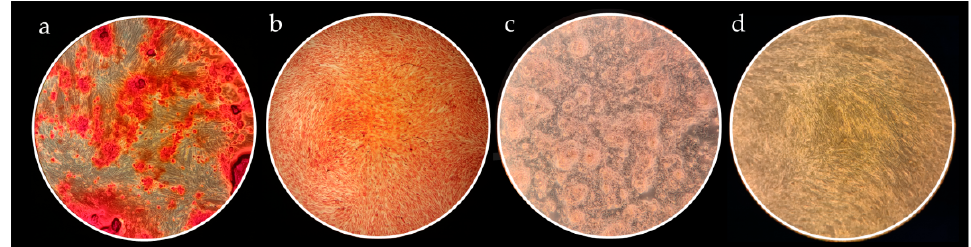
Figure 7. Histological evaluation ofSCAP multilineage differentiation capacity. All micrographs were taken at 40× magnification. ( a ) Alizarin Red S staining of calcium deposits showing osteogenic potential of SCAP; ( b ) Safranin O staining of proteoglycan aggregates evidencing successful SCAP chondrogenic potential; ( c ) Oil Red O positive staining of intracellular lipid droplets as a sign of SCAP adipogenicdifferention; ( d ) Representative image of unstained controls.